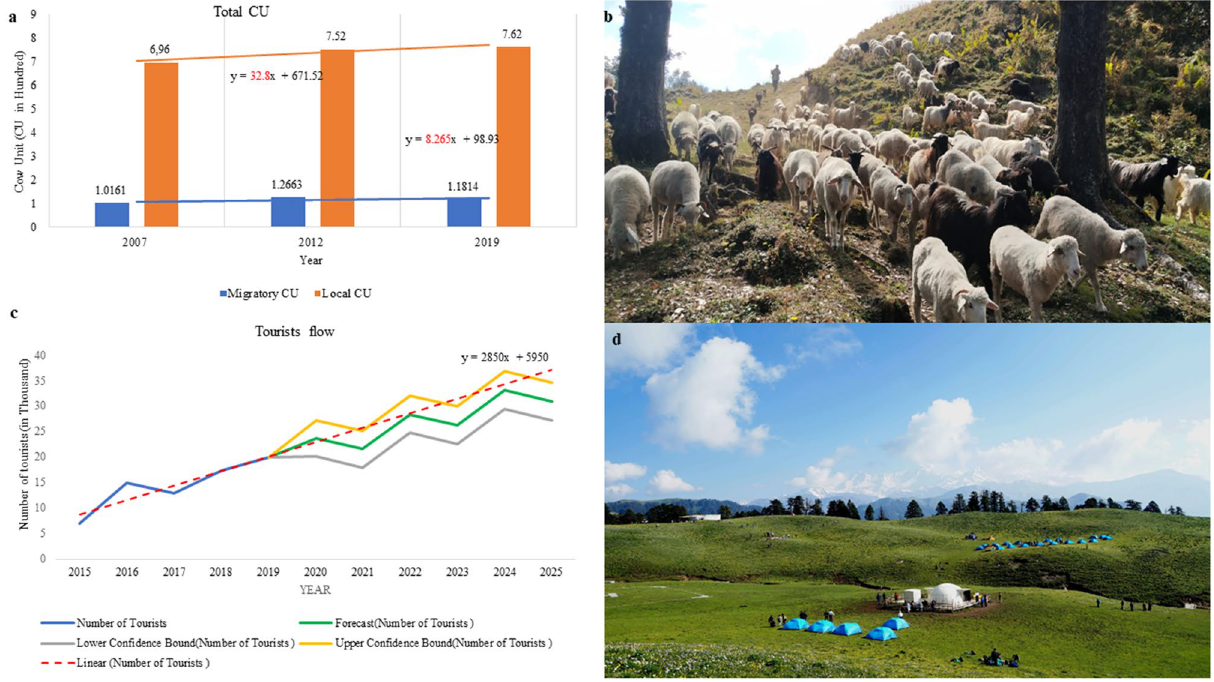
Figure 2. Anthropogenic interference at Dayara bugyal: ( a ) total cow unit of the area from 2007 to 2019, ( b ) return of animals from the Dayara bugyal before upcoming winter season, ( c ) time series analysis of tourists’ influx in the Dayara (2015–2025), and ( d ) tourists’ influx and their camping in the Dayara before the restoration period (2d-Photo credit: Mr.Santosh Saklani, Uttarakashi).